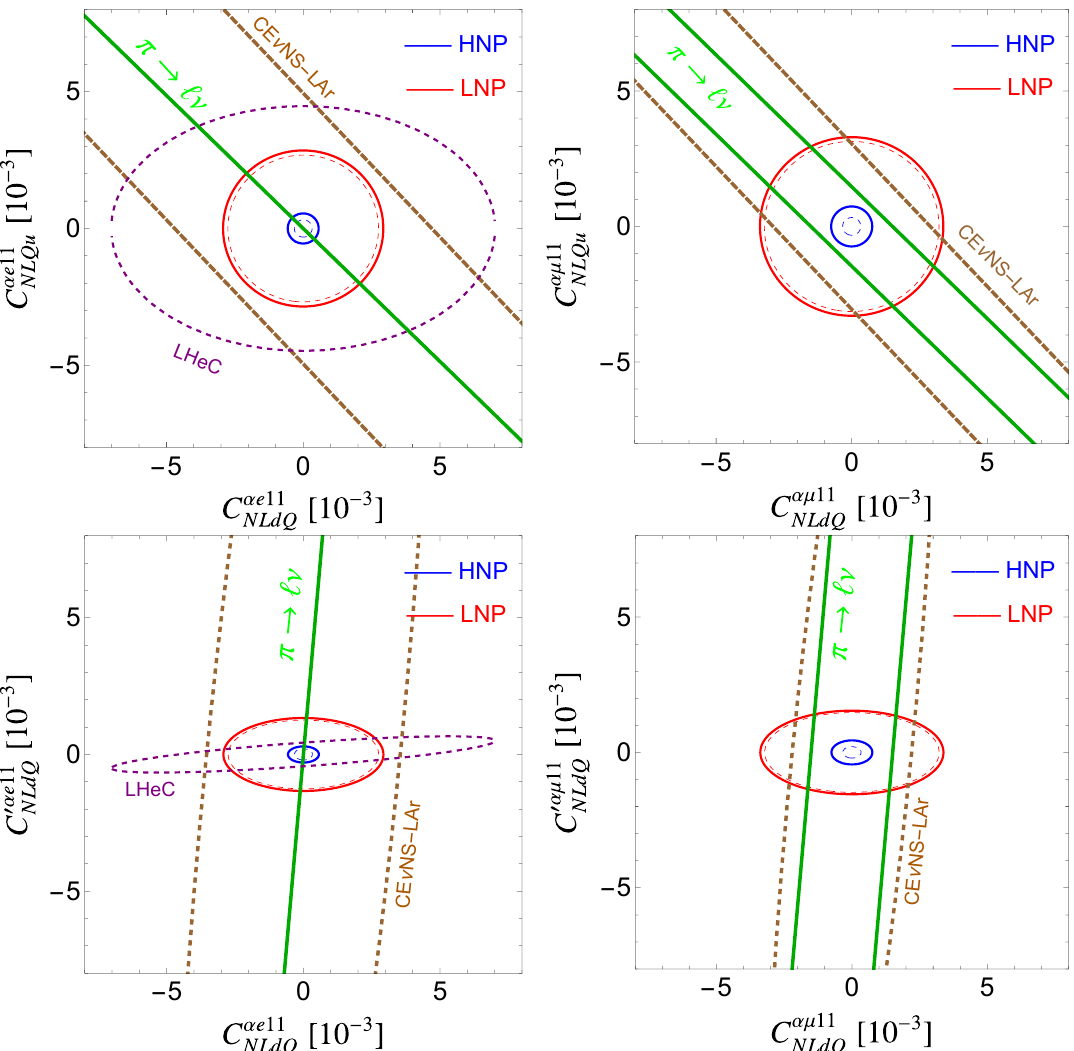
Figure 1. The 90% C.L. allowed regions in the C NLdQ - C NLQu planes (upper panels) and C NLdQ - C 0 planes (lower panels) at 1 TeV with electron (cid:13)avor (left panels) and muon (cid:13)avor (right NLdQ panels). The green lines (overlapping in the left panels) are the bounds from pion decay with the third parameter is set to zero to break the degeneracy. The red (blue) solid contours correspond to current LHC searches with L = 139 fb (cid:0) 1 for the low-scale new physics LNP (high-scale new physics HNP) case. The brown dashed lines show the projected bounds from the future LAr COHERENT experiment, with C NLQu is set to zero in the lower panels to obtain meaningful bounds. The red and blues dashed contours are the projected bounds from HL-LHC with 3 ab (cid:0) 1 of data. The dashed purple contours in the left panels are the projected bounds from LHeC with 3 ab (cid:0) 1 .